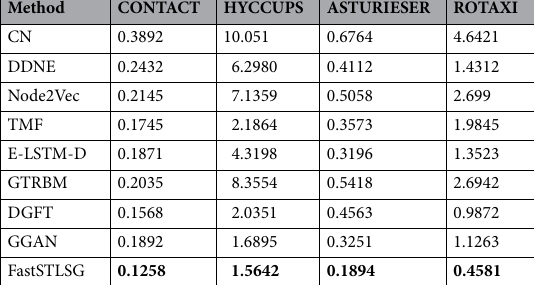
Table 7. Performances on RMSE for different methods. Significant values are in bold.